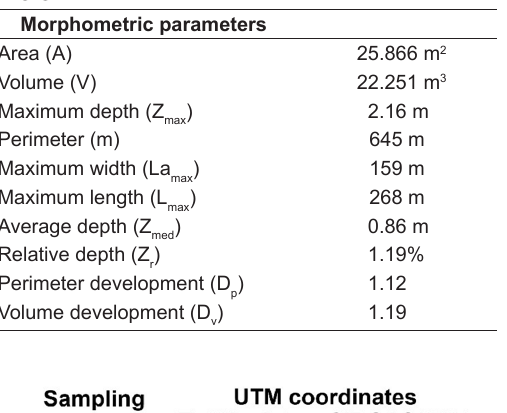
Table 1. Morphometric parameters of the FEENA reservoir (Cigagna et al.,